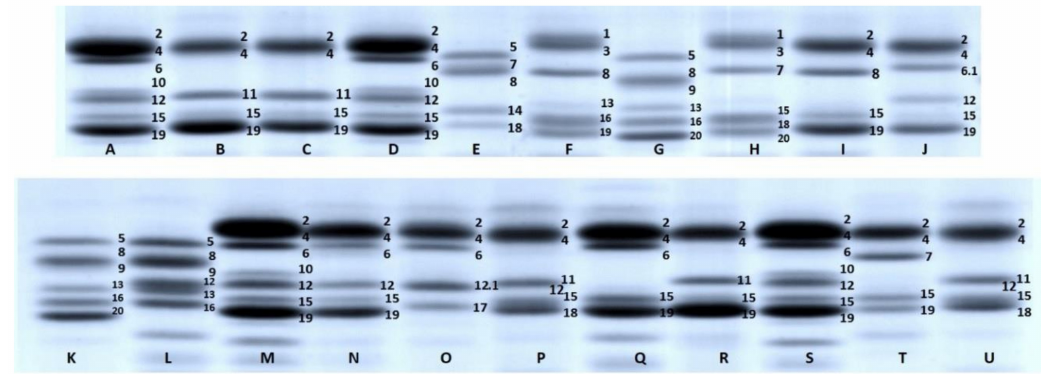
Figure 2. LMW-GS composition observed in a durum wheat collection of Moroccan landraces. Lanes